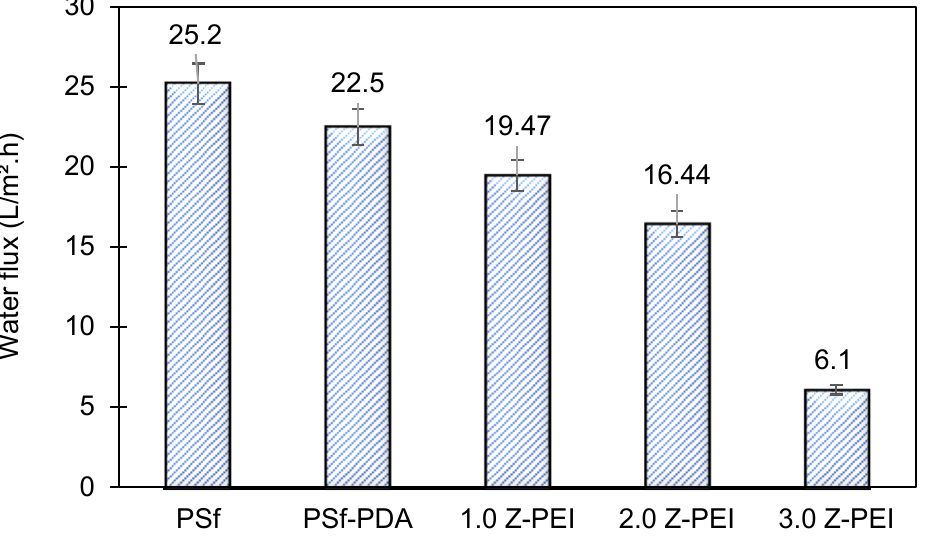
Figure 6. Water flux of all prepared membranes.